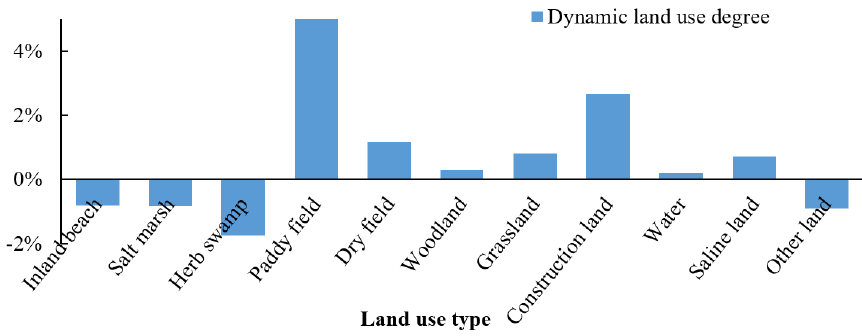
Figure 8. Momoge Internationally Important Wetland dynamic land use degree